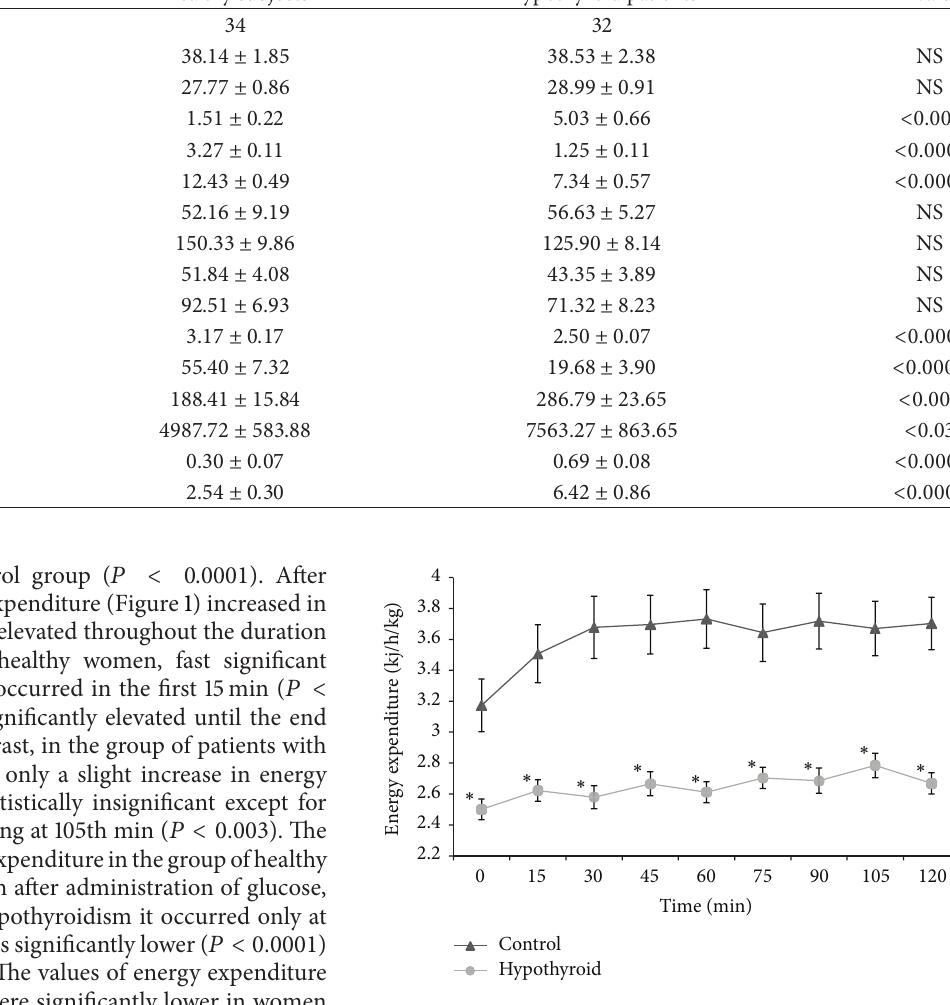
Figure 1: Mean values ± SE of RMR and changes in energy expen- diture during 2h OGTT in the group of hypothyroid (hypothyroid) and healthy women (control). Asterisks denote differences between these groups; ∗ 𝑃 < 0.0001